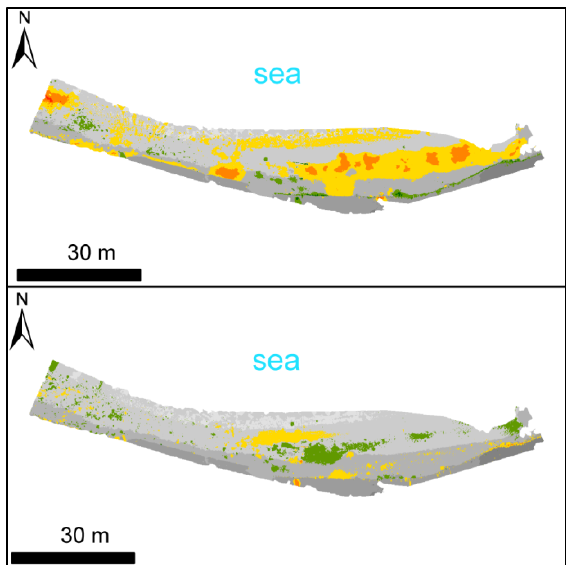
Figure 5: Annual changes of Kaminia Beach; top: 2009-2010 and bottom: 2010-2011 (legend see fig.